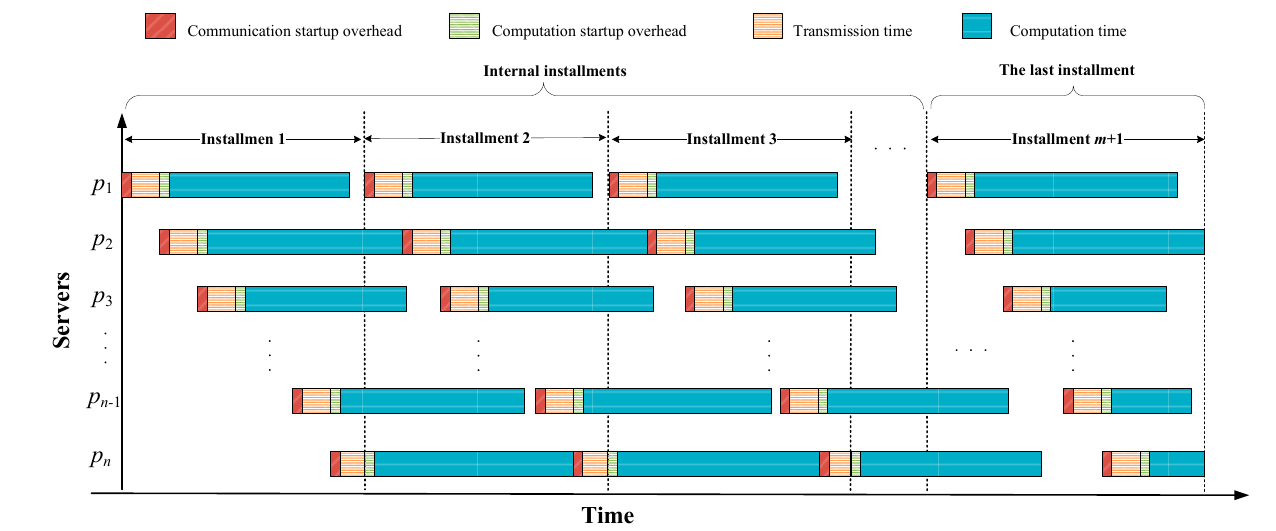
Figure 1. Multi-installment scheduling for coarse-grained divisible loads. Table 1. Notations and their